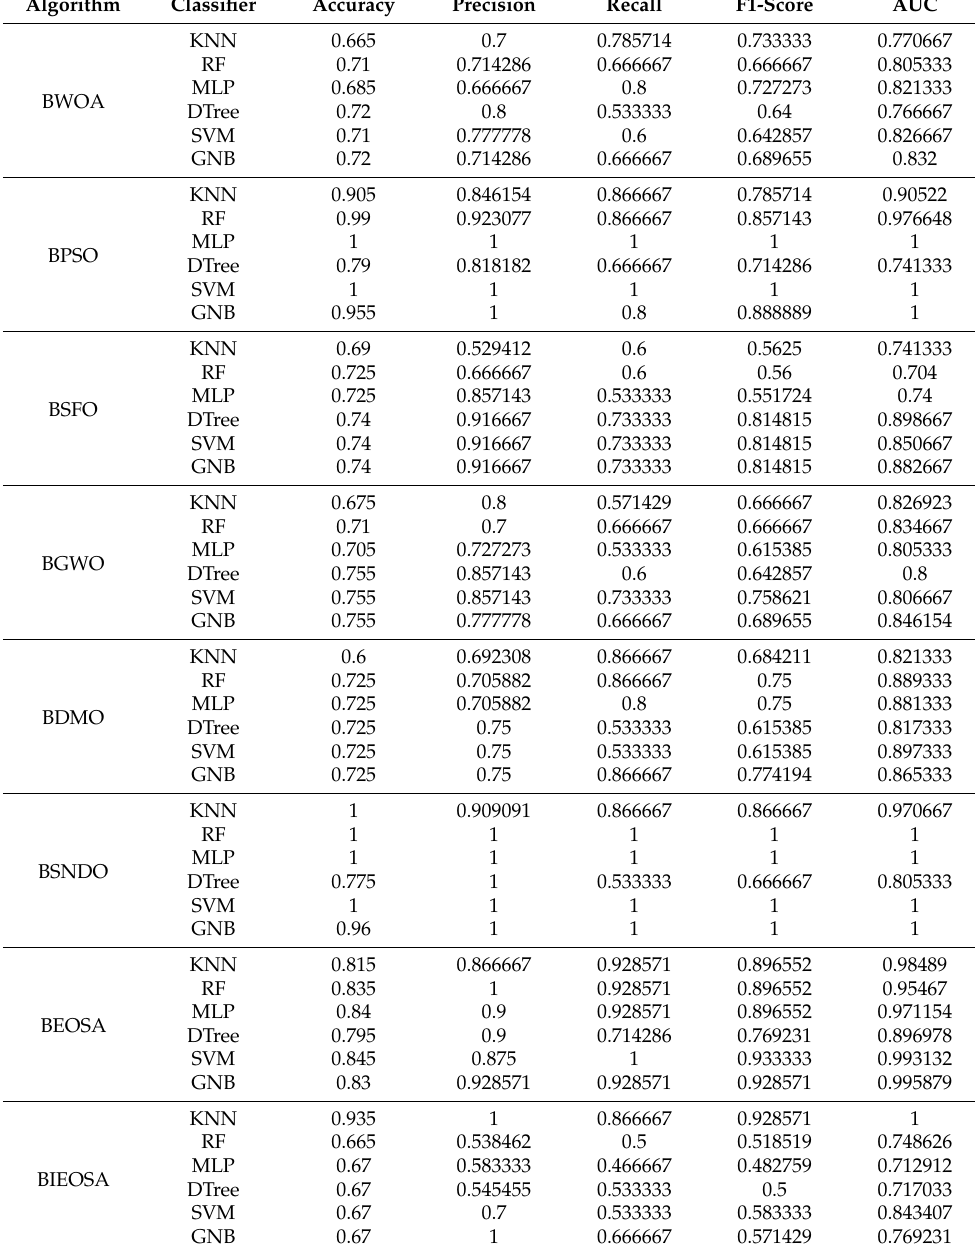
Table 6. The classification accuracy, precision, recall, F1-score and area under curve (AUC) report for the M-of-n datasets using KNN, random forest (RF), MLP, Decision Tree (DTree), SVM, and Gaussian naïve Bayes (GNB) classifiers on the BWOA, BPSO, BSFO, BGWO, BDMO, BSNDO, BEOSA and BIEOSA